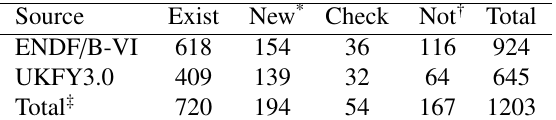
Table 2. The number of FPY references categorised during our assessment for those cited in evaluation summaries of ENDF / B-VI [11] and UKFY3.0 [12]. See the main text for the definition of each